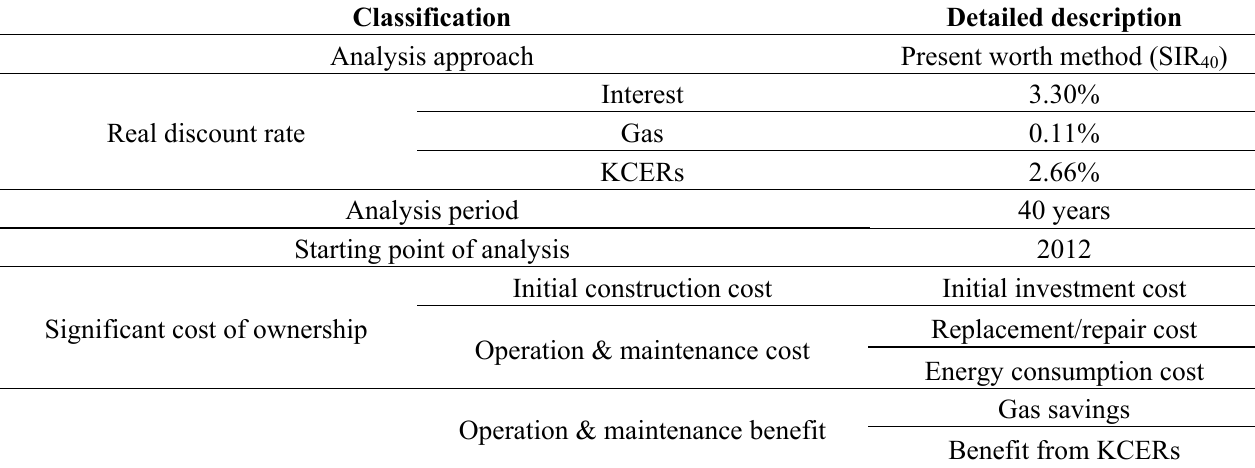
Table 7. Key elements of the LCC and LCCO